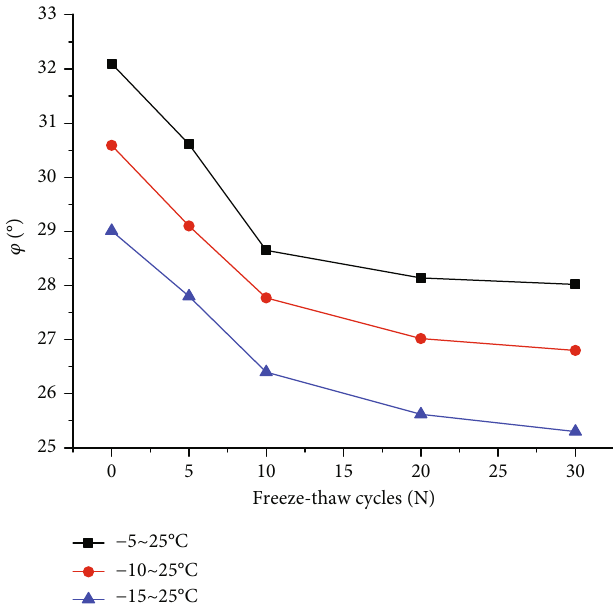
Figure 12: Relationship between freeze-thaw cycles and internal friction angle.